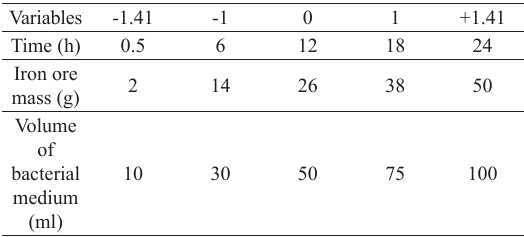
Table 3. Levels used in the factorial planning.